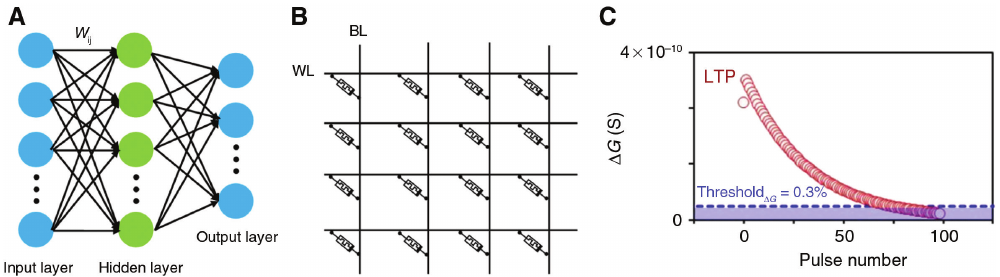
Figure 8: Schematic plot of an artificial neural network and its computing principle. (A) The structure of a feed forward artificial neural network. (B) Schematic logic computing principle using one memristor in crossbar architecture. (C) Number of effective conductance states extraction at a threshold Δ G of 3%. Reproduced with permission [13]. Copyright 2019, Nature Publishing